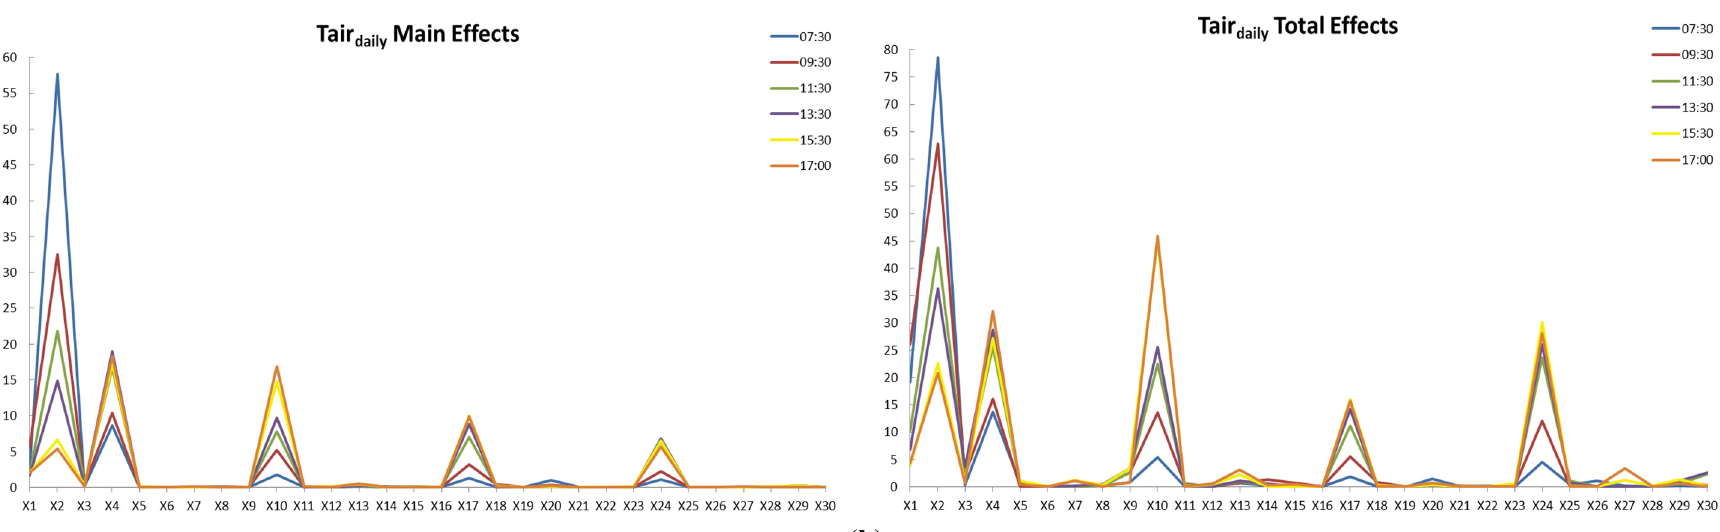
Figure 2. Line graphs summarising the main and total effects of each input parameter for each model output for the six model output times. The main and are shown. The y-axis represents the percentage variance of each input parameter on the model